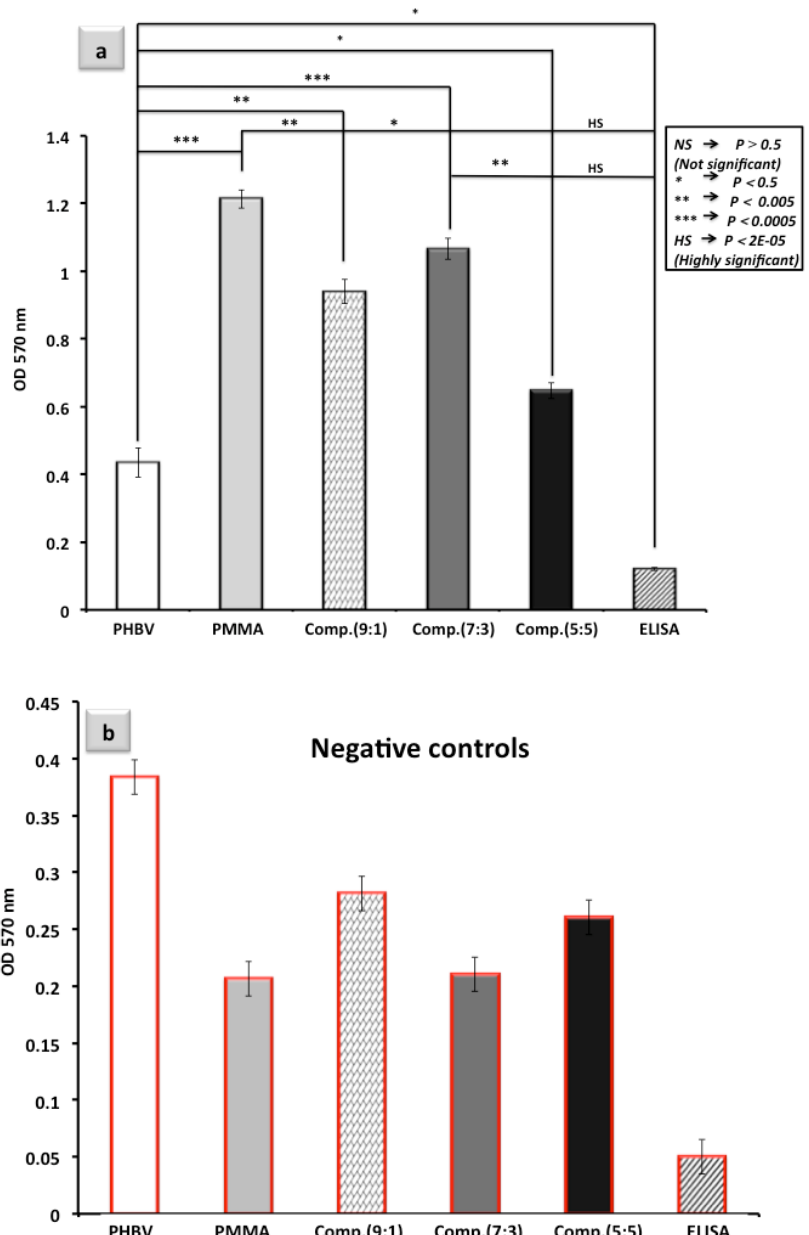
Figure 6. Sandwich ELISA performed on different fiber mats (DENV concentration = 3.5 × 10 − 2 p.f.u/mL): ( a ) detection signal intensity resulted from i-ELISA conducted with coated PHBV fiber mats with different compositions of poly(MMA-co-MAA) (data are plotted after subtracting the cut-off values from the actual detection results); and ( b ) negative control signals obtained from the assay conducted in the absence of DENV.